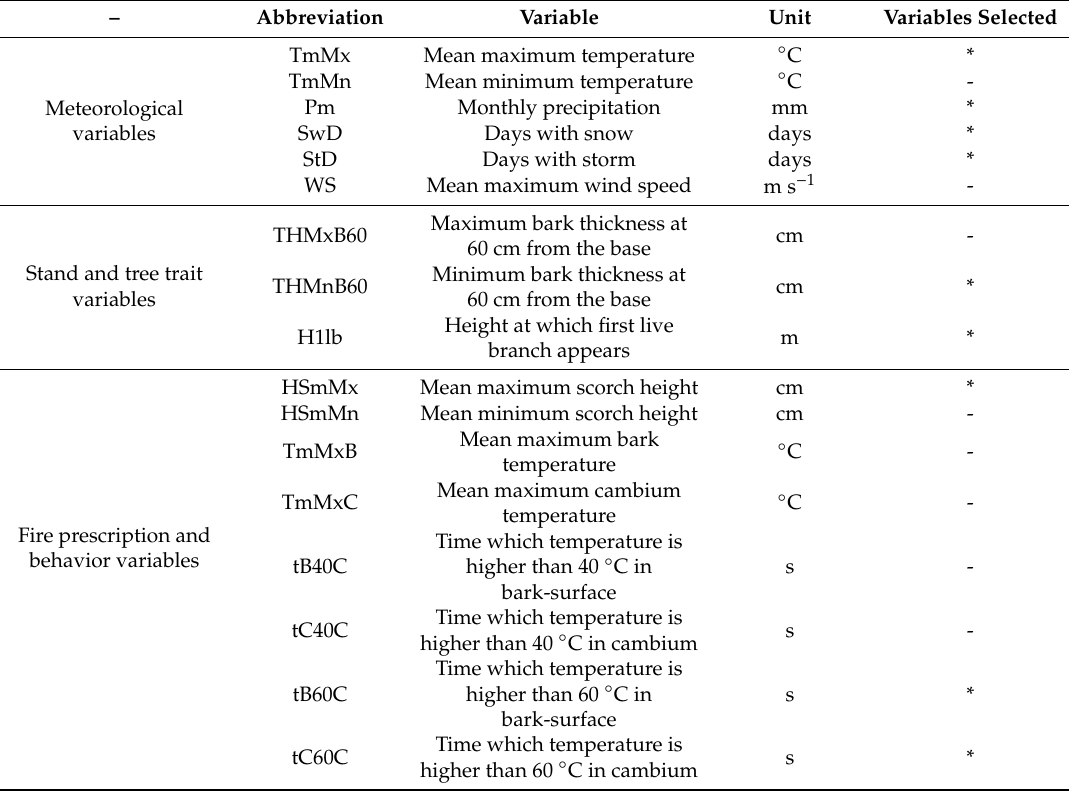
Table 4. Variables (fixed e ff ects) combined in the models and variables selected by the best fit